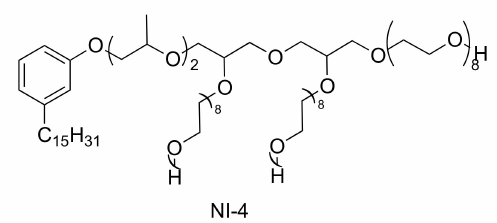
Figure 7. Branched ethoxylated surfactant based on cardanol